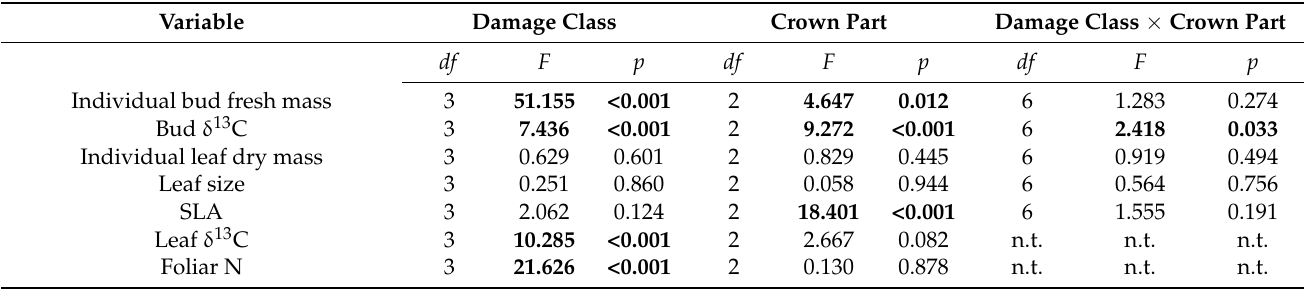
Table 2. Results of Two-Way ANOVA applied to variables of buds (harvested in autumn 2020) and leaves (sampled in spring 2021) of different damage classes and crown parts of European beech saplings subjected to severe drought stress in spring and summer 2020. Significant results are printed in bold. n.t.—not tested due to unbalanced design (missing data in the upper crown